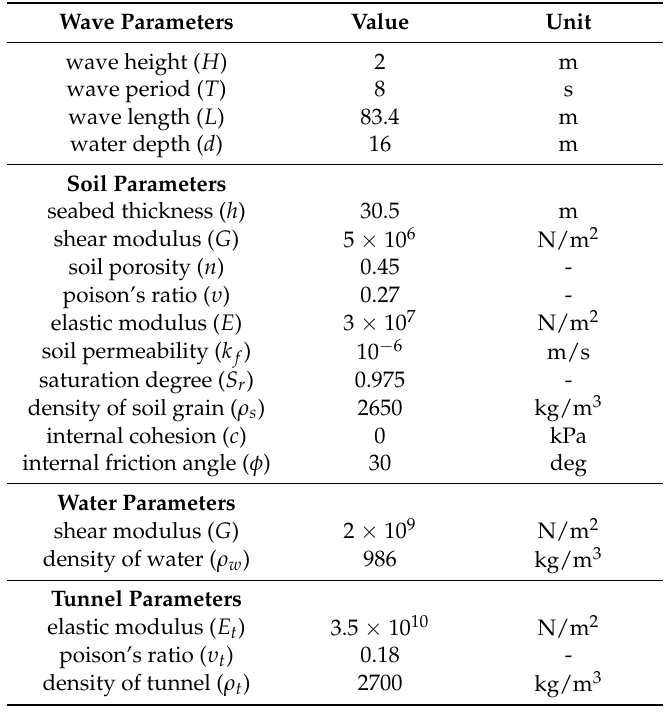
Table 2. The input data of a standard case for parametric study.